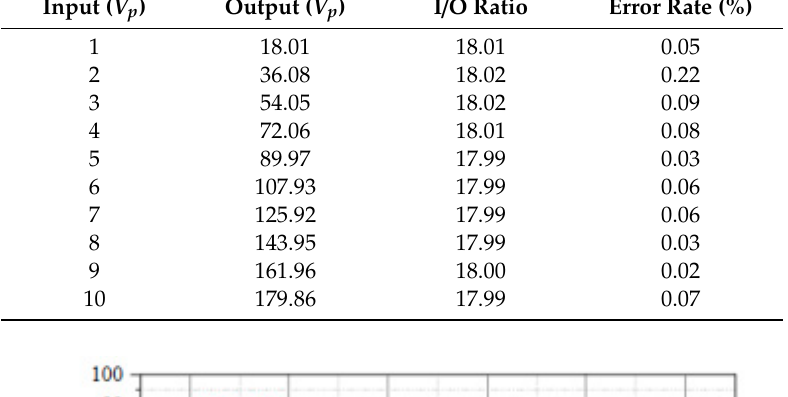
Table 3. Verification result for voltage amplifier.